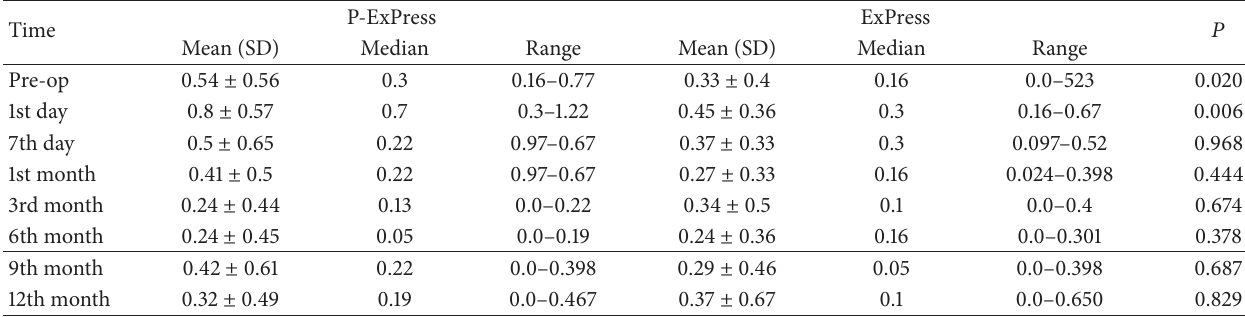
Table 4: Visual acuity (logMAR) mean values, median values, standard deviations, and range in the phaco-ExPress (P-ExPress) and ExPress (ExPress) groups at specific times after surgery.